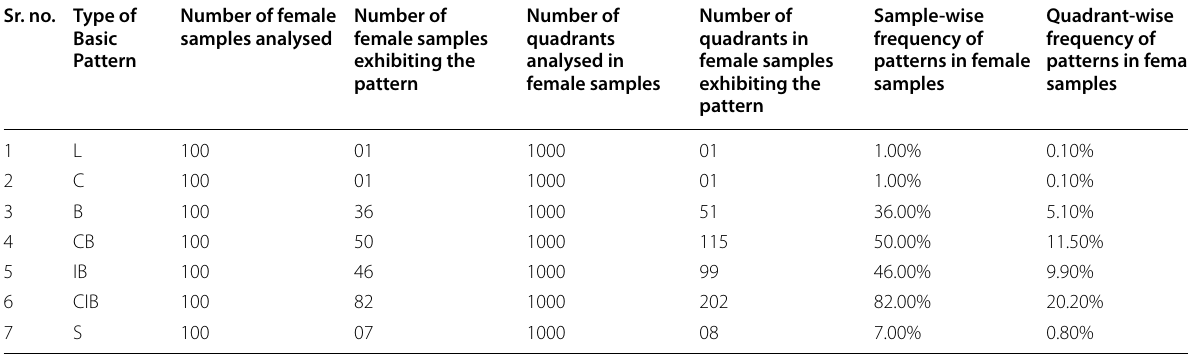
L , lines; C , curves; B , bifurcations; CB , curved bifurcations; IB , intersected bifurcations; CIB , curved intersected bifurcations; S , squares Table 7 Frequency of Basic Patterns in male samples Sr. no. Type of